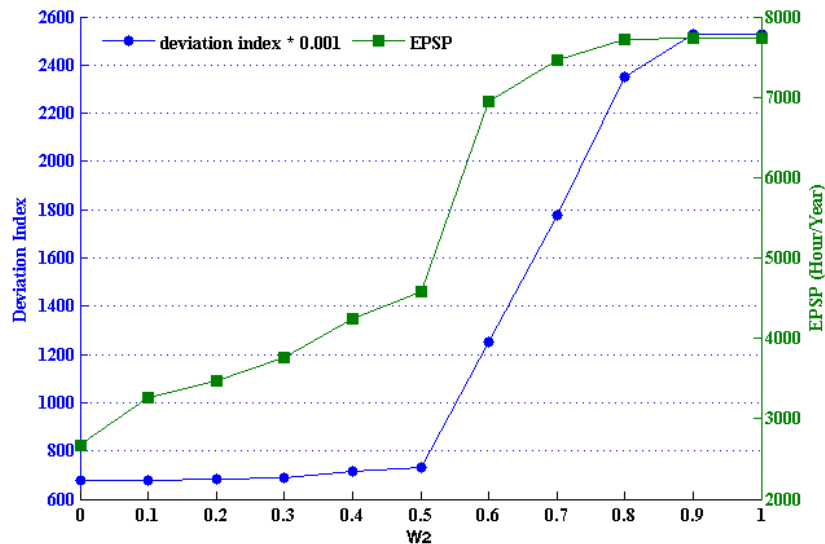
Figure 3. Expected price shortage period and deviation index versus the weighting factors.